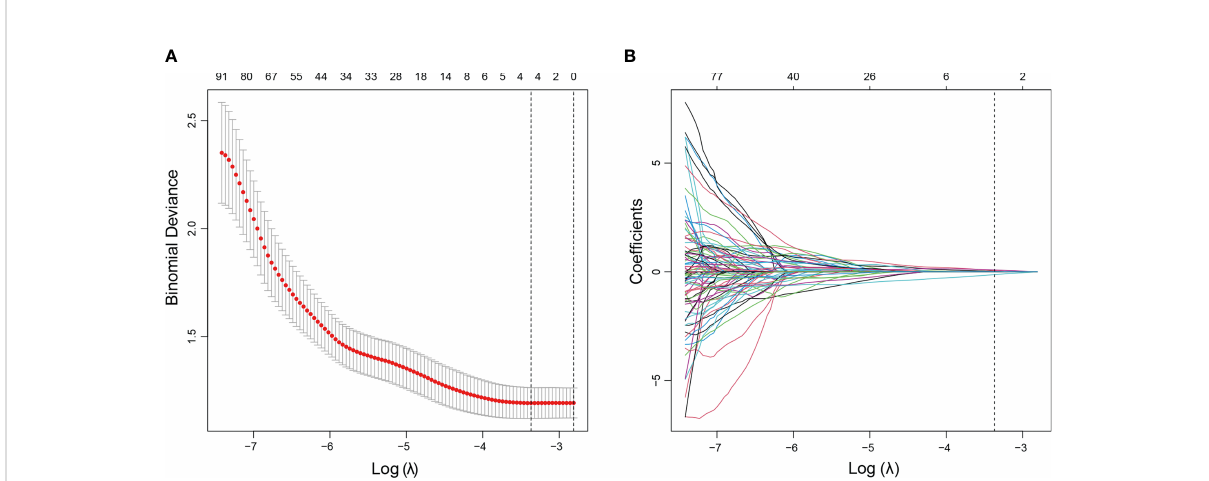
FIGURE 2 US radiomics feature selection using LASSO logistic regression model in the training cohort. (A) The tuning parameter ( l ) was selected using 10- fold cross-validation via minimum criteria. Dotted vertical lines were drawn at the optimal values using the minimum criteria and 1 standard error of the minimum criteria (1 − SE criteria). A l value of 0.0273, with a log ( l ) value of − 3.601, was obtained. (B) The vertical line was drawn at the value selected using 10-fold cross-validation, where optimal l resulted in four non-zero coef fi cients. LASSO, least absolute shrinkage and selection operator.